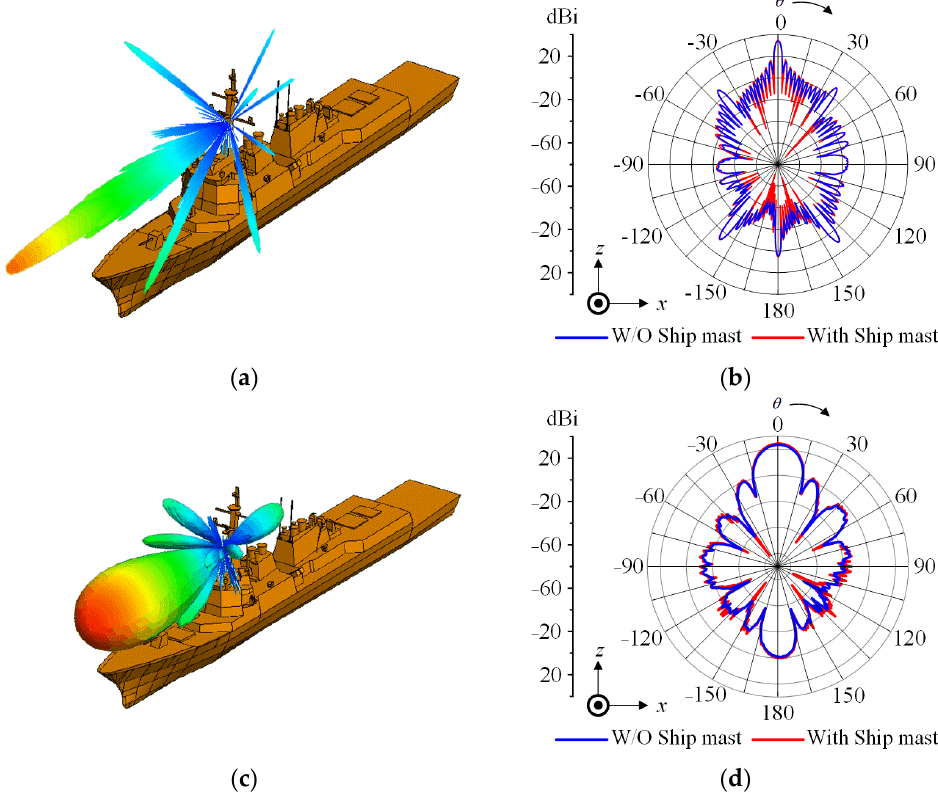
Figure 9. Simulated radiation patterns before and after mounting on the ship mast: ( a ) 3D radiation patterns after mounting on the ship mast in the X-band; ( b ) radiation patterns before and after mounting on the ship mast in the X-band; ( c ) 3D radiation patterns after mounting on the ship mast in the S-band; ( d ) radiation patterns before and after mounting on the ship mast in the S-band.